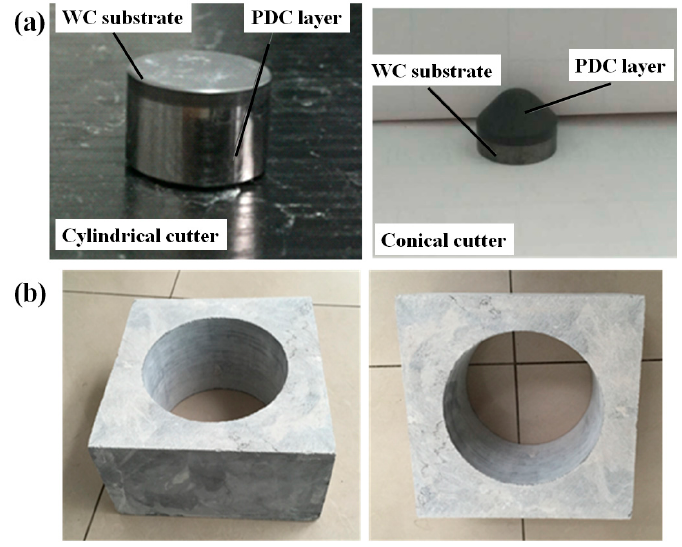
Figure 2. ( a ) PDC cutter and ( b ) rock samples. Table 1. Physical properties of limestone used in this study.